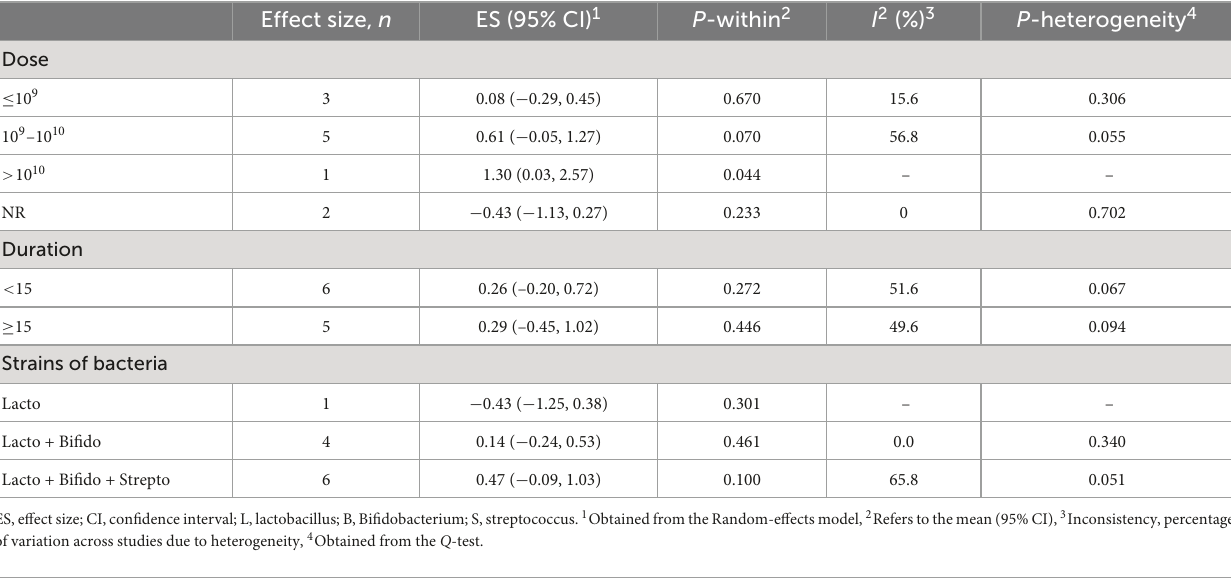
(ChREBP)/sterol regulatory element-binding protein